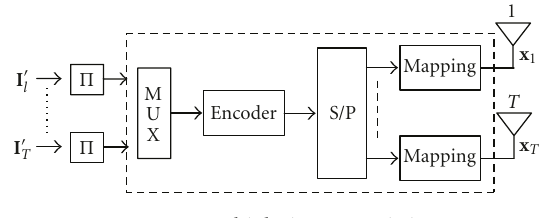
Figure 4: Multiplexing